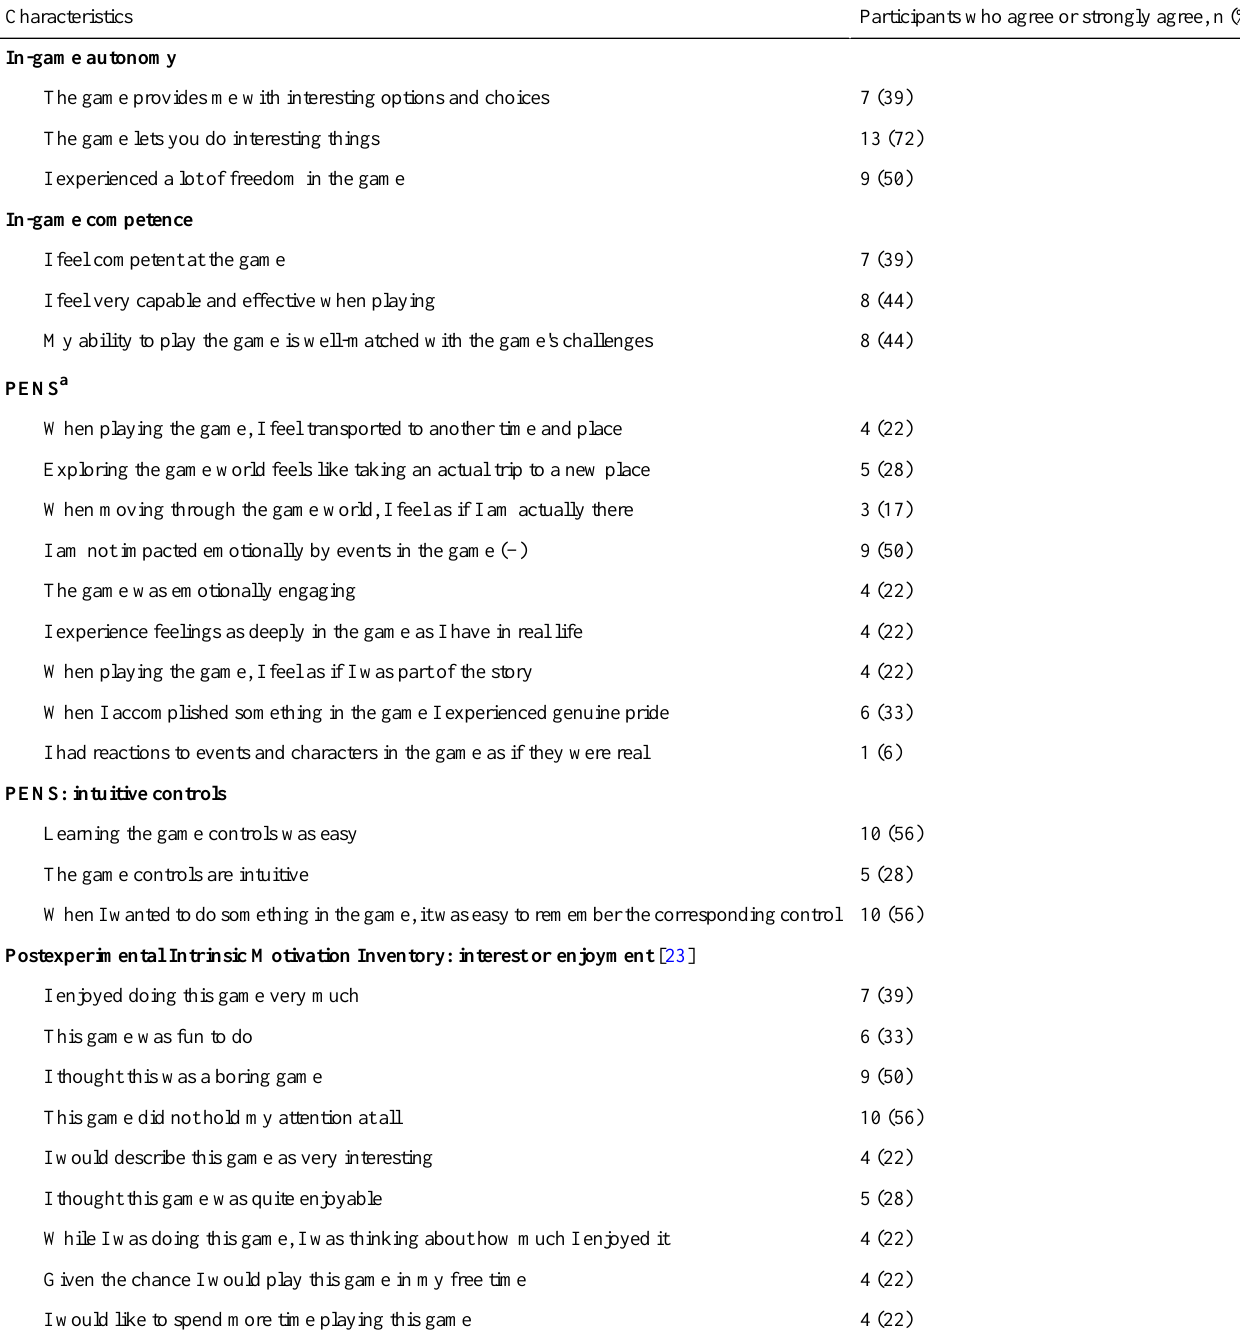
Table 2. Measurements from the Physical/Emotional/Narrative Presence Scale